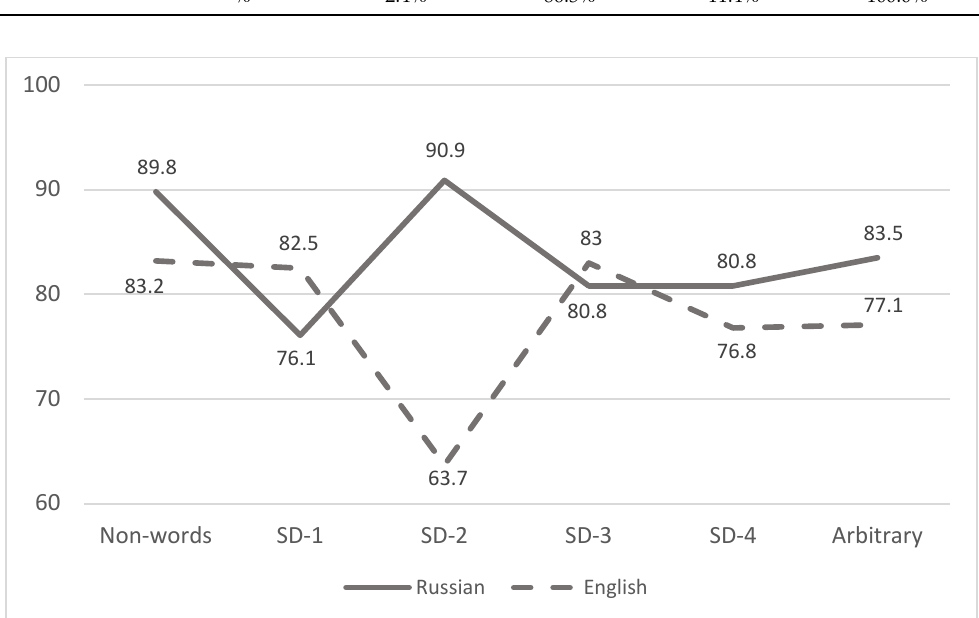
Figure 1. Accuracy rates for visual recognition of the English and Russian stimuli.